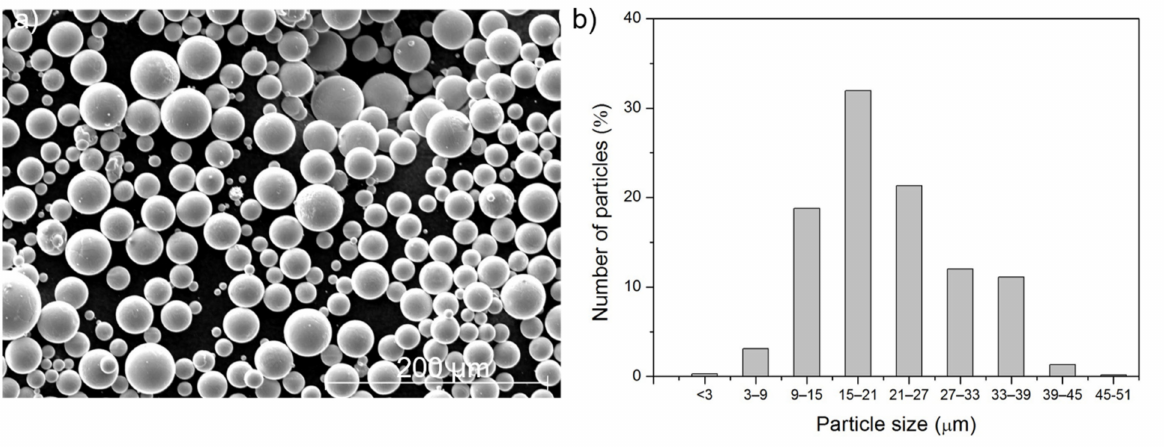
Figure 1. ( a ) SEM image of the Ti-6Al-4V powder; ( b ) particle size distribution of the powder